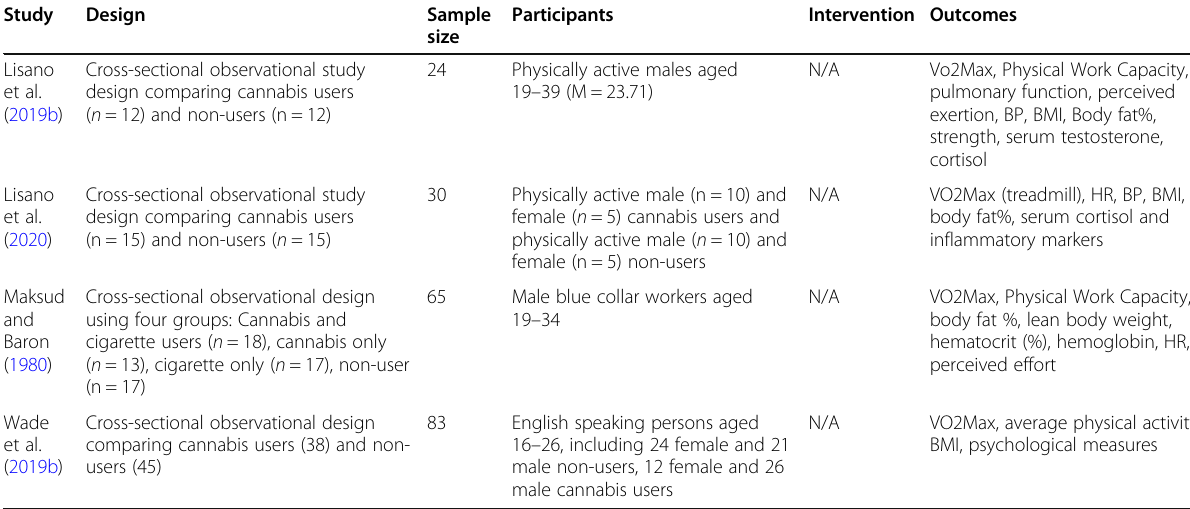
Table 2 Summary of included